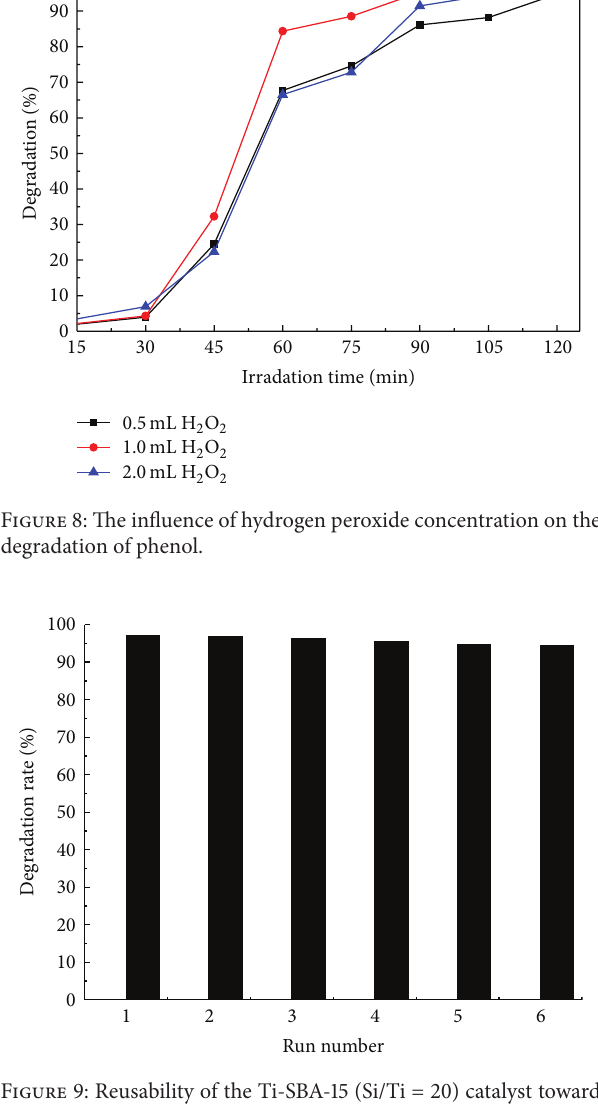
Figure 9: Reusability of the Ti-SBA-15 (Si/Ti = 20) catalyst toward the degradation of phenol in